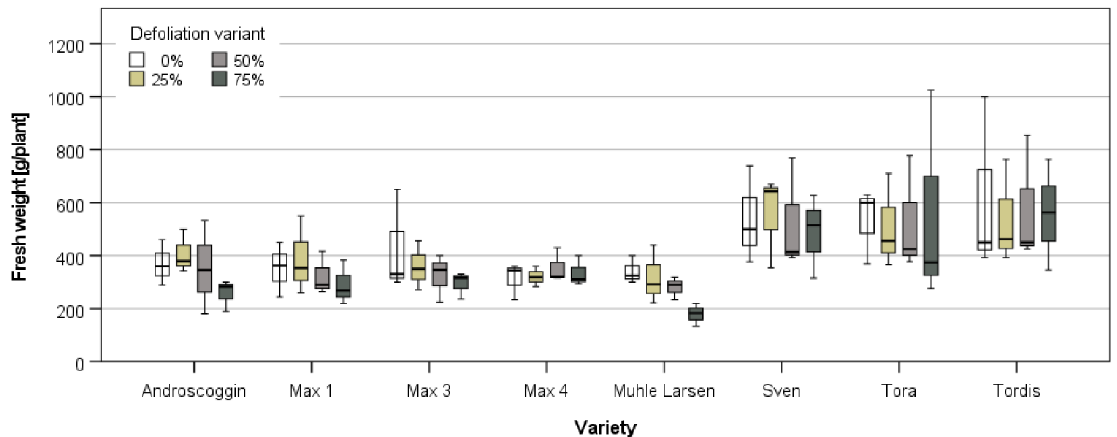
Figure 4. Fresh weight of aboveground biomass of plants on the study site in Großthiemig in February 2009 (n per variety and defoliation variant = 3 by not taking into account the number of defoliations).